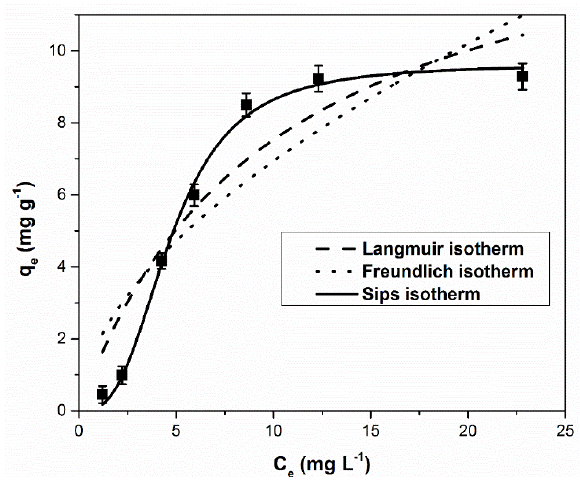
Figure 7. Equilibrium isotherms for adsorption of Pd(II) ions onto MgSiO3-cys. Table 1. Parameters of isotherm models for adsorption of palladium ions onto MgSiO 3 -cys.